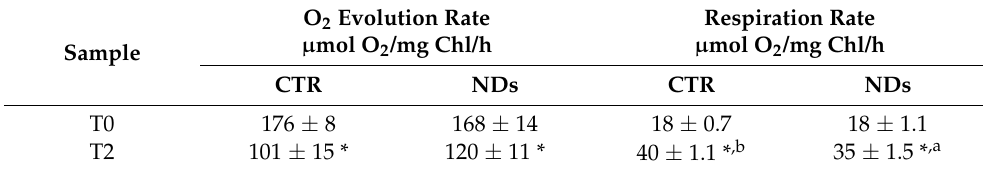
Table 2. High light-induced changes in the O 2 evolution and respiration rate of C. reinhardtii cul- tures pre-incubated with 40 µ g hNDs/mL for 24 h and in the control cells. Respiration rate and light-induced O 2 evolution were measured after 3 min of dark adaptation and under PPFD of 1500 µ mol/m 2 /s, respectively, in the presence of 2 mM NaHCO 3 . Means of 2 independent experi- ments with 3 biological replicates ( ± SD, n =